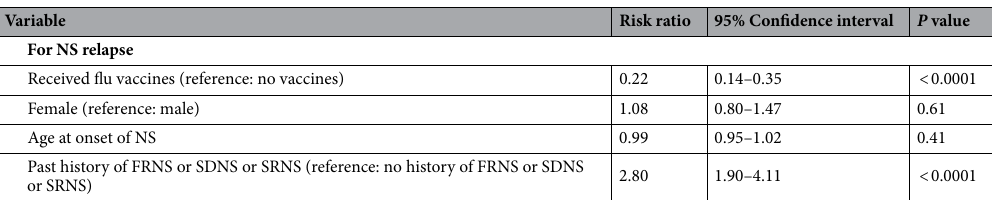
Table 4. Risk ratio for nephrotic syndrome relapse in 306 children who received and did not receive flu vaccination (multivariate analysis). NS; nephrotic syndrome, Flu; influenza virus, FRNS; frequently relapsing NS, SDNS; steroid-dependent NS, SRNS; steroid-resistant NS.